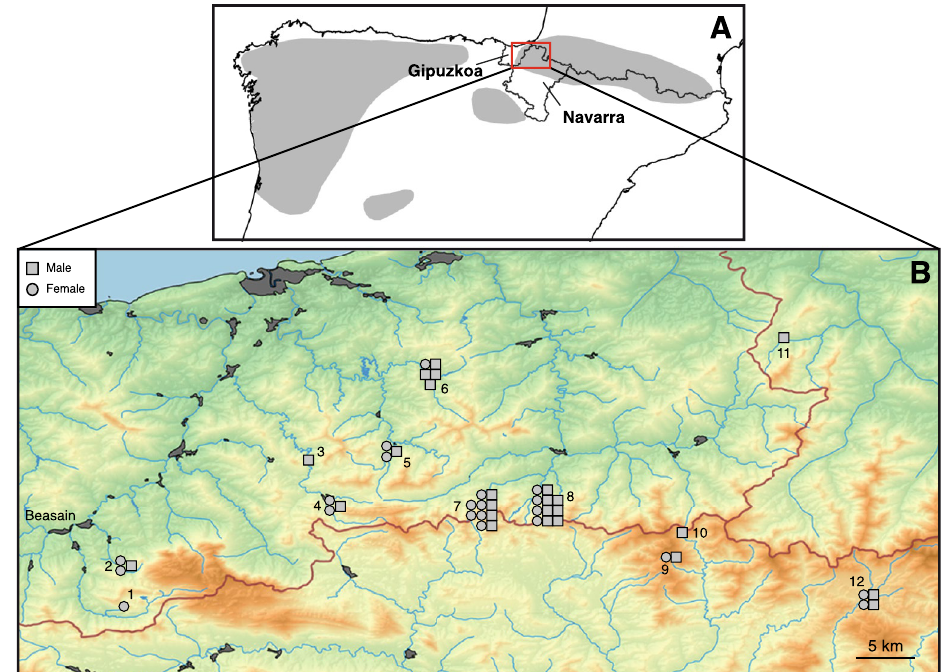
Figure 1. ( A ) Map of the Iberian Peninsula showing the Iberian desman distribution range in grey. The study area is indicated with a red square. ( B ) Enlarged map showing the localities of the Iberian desmans used in this work. Each sampled individual is represented with different symbols for males (squares) and females (circles). The numbers indicate the localities (1: Aiaiturrieta-Ataun; 2: Amundarain-Zaldibia; 3: Leitzaran-Berastegi; 4: Erasote-Leitza; 5: Urumea; 6: Elama-Artikutza; 7: Ameztia-Labaien; 8: Ezpelura-Urrotz; 9: Sasoaran-Eugi; 10: Olazar-Eugi; 11: Aritzakun; and 12: Urrobi-Auritz). Red lines delimit the three main river basins: Cantabrian at the northwest, Adur at the northeast, and Ebro at the south. Populations 1 and 2 are possibly extinct. Human population nuclei with more than 500 inhabitants are indicated in dark gray. The map was constructed using QGIS 2.14 53 . The distribution range of Galemys pyrenaicus was generated using information from different sources 13,54 . The coastline shapefile was downloaded from Natural Earth (https:// www. natur alear thdata. com). The shapefiles of the shaded relief map, rivers, main river basins, and human population nuclei were downloaded from Instituto Geográfico Nacional (https:// www. ign. es). The river shapefile for France was obtained from DIVA-GIS (https:// www. diva- gis.